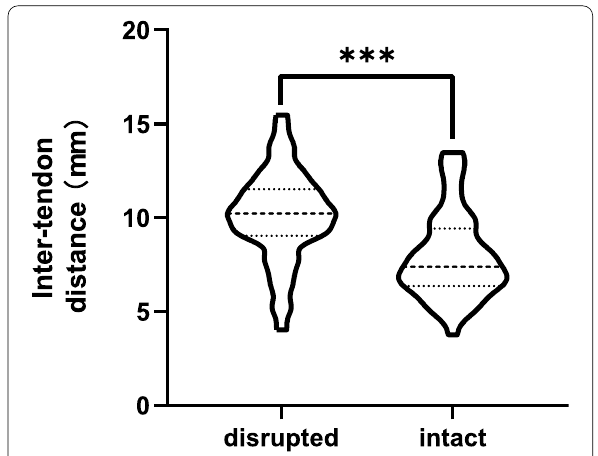
Fig. 2 Differences in inter-tendon distance between the two groups. Inter-tendon distance in patients with anterior supraspinatus muscle injury was significantly larger than that in the intact group